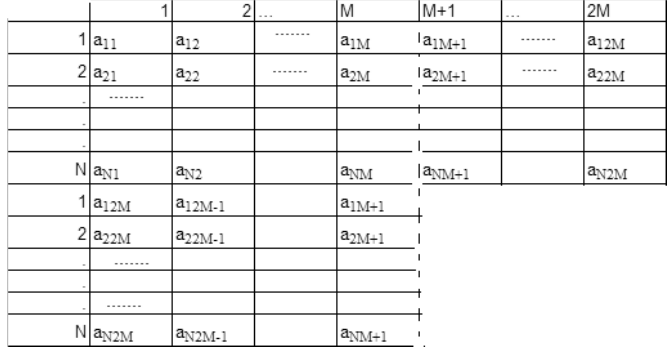
Fig. 3. The matrix of stakeholders'contributions in a CSR